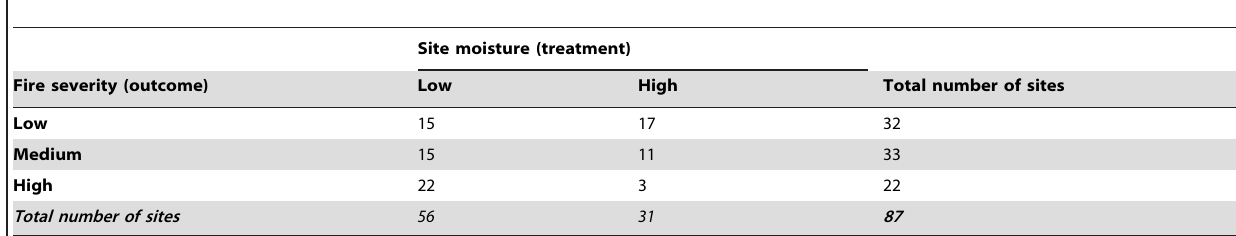
Table 2. Chi-squared contingency table to evaluate whether there is a significant difference in distribution of sites based on moisture and